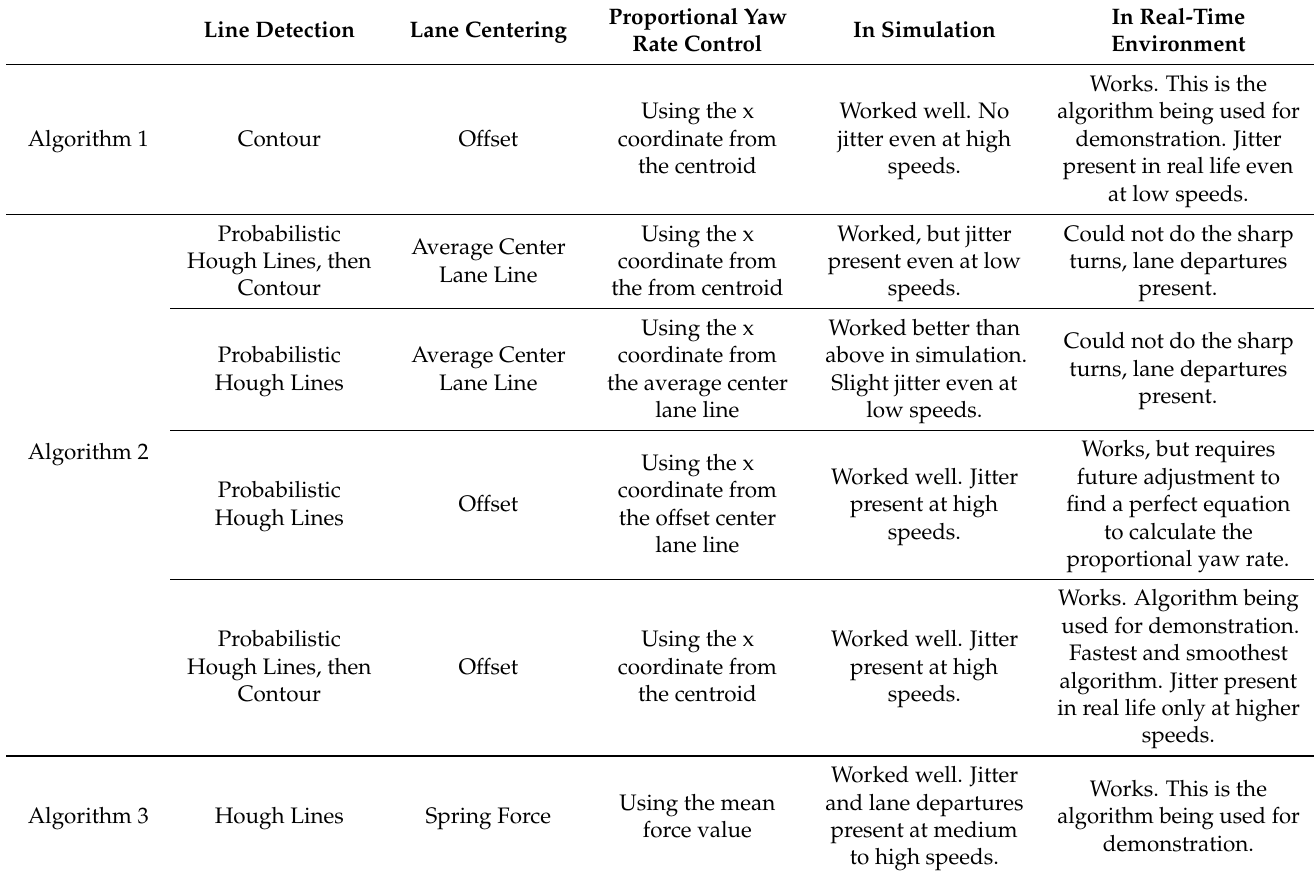
Table 2. Summary of the algorithms